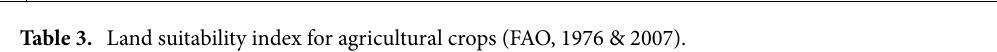
Table 3. Land suitability index for agricultural crops (FAO, 1976 & 2007).